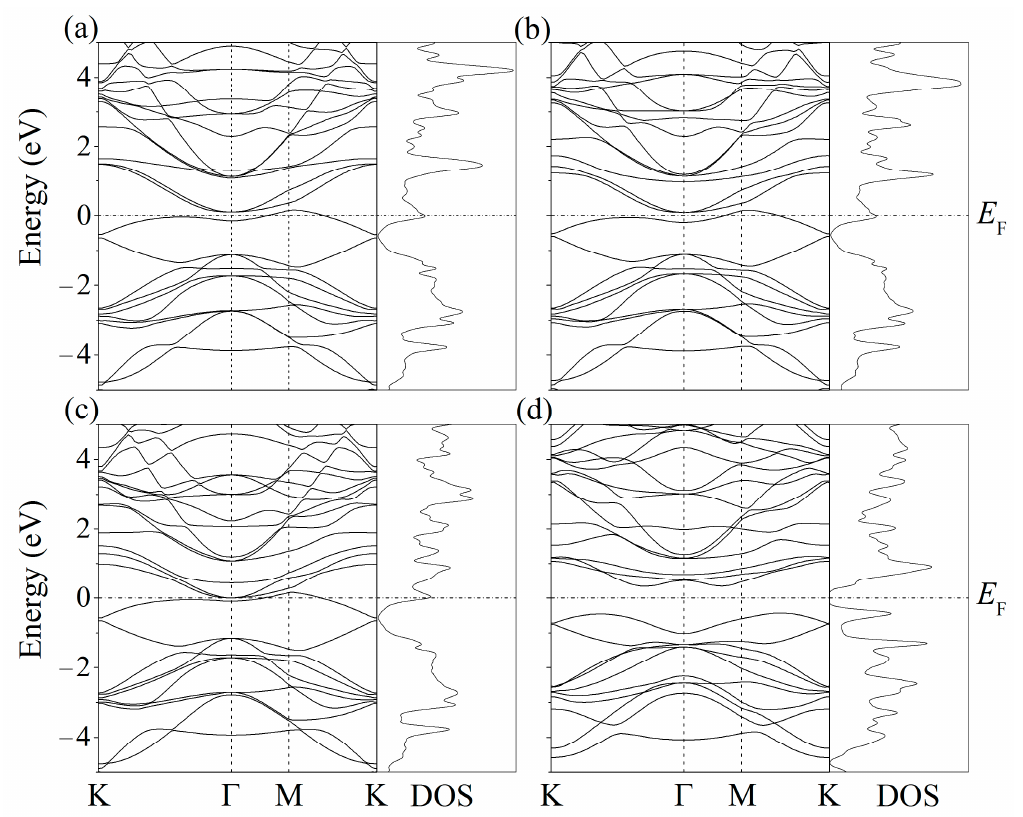
Figure 11. Band structure and density of electronic states (DOS) of silicene after adsorption of a metal atom (( a )—Li, ( b )—Na, ( c )—K, and ( d )—Mg) in a position above the center of a six-unit Si ring.